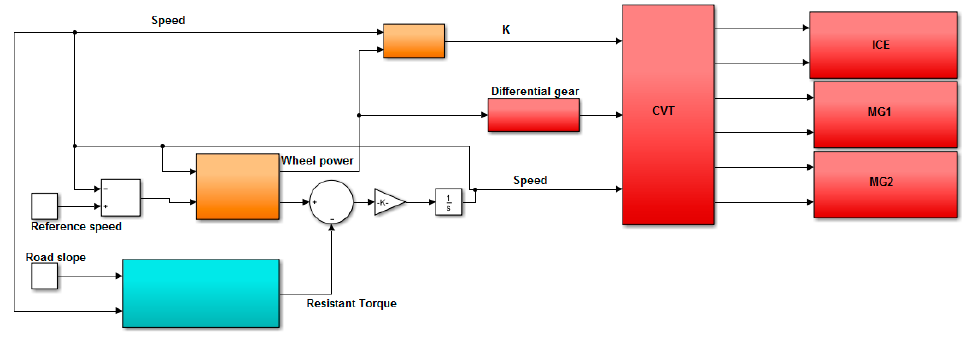
Figure 10. CVT MATLAB/Simulink model.